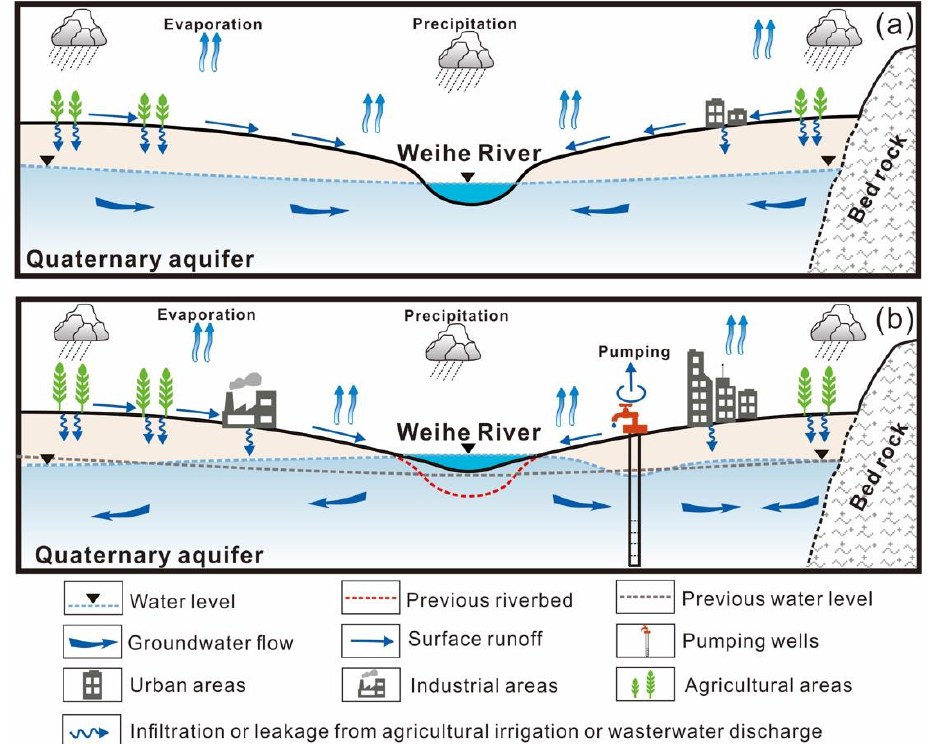
Figure 11. Conceptual diagram of the SW – GW interaction integrated with potential anthropogenic inputs: ( a ) before the dam operation, ( b ) at current status.